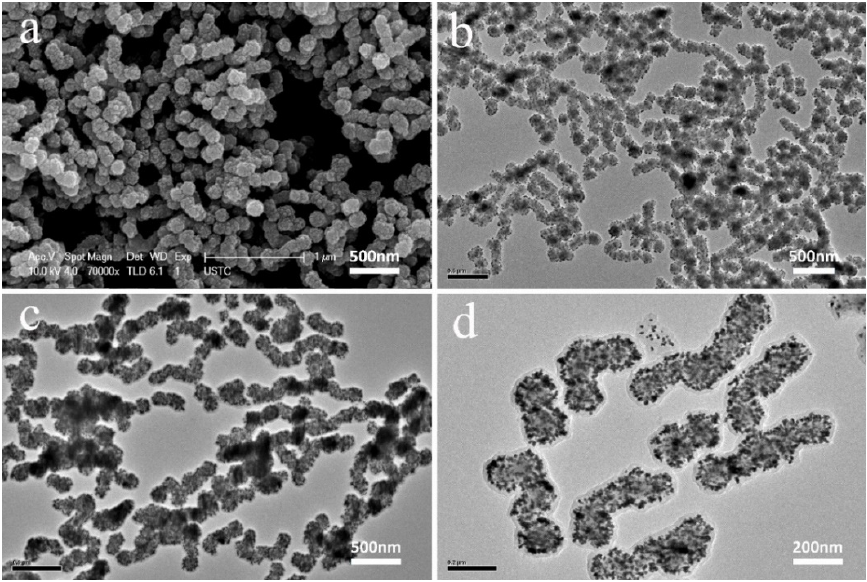
3 O 4 @SiO 2 @Au/PDA